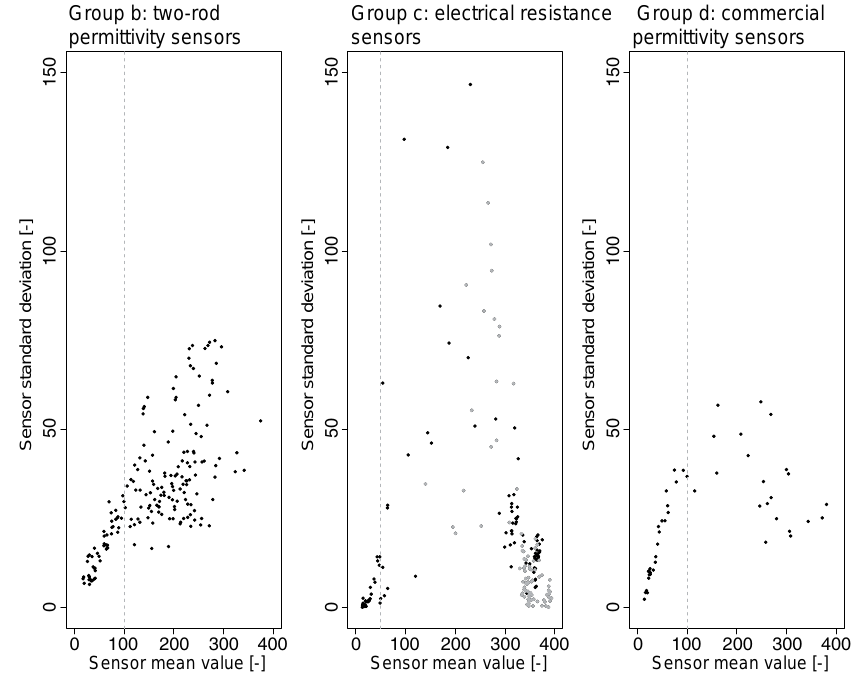
Figure 6. Standard deviation of the different sensor groups as a function of sensor mean value. Gray dots indicate standard deviations and means that were calculated from two observations only. The dashed gray line represents the threshold sensor mean value that was determined visually to limit the values to a range where sensor mean value and sensor standard deviation were more correlated. Group a was left out as it consists of one sensor